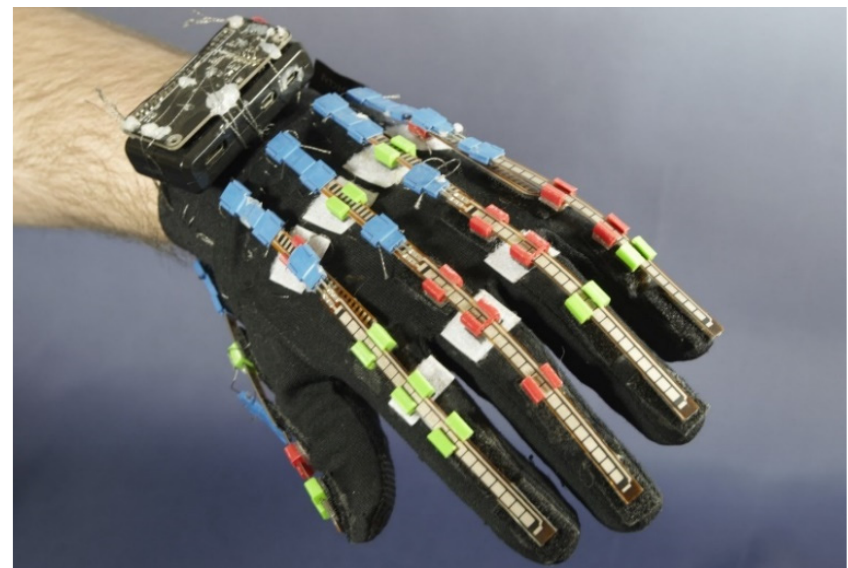
Figure 2. The glove used in the study.